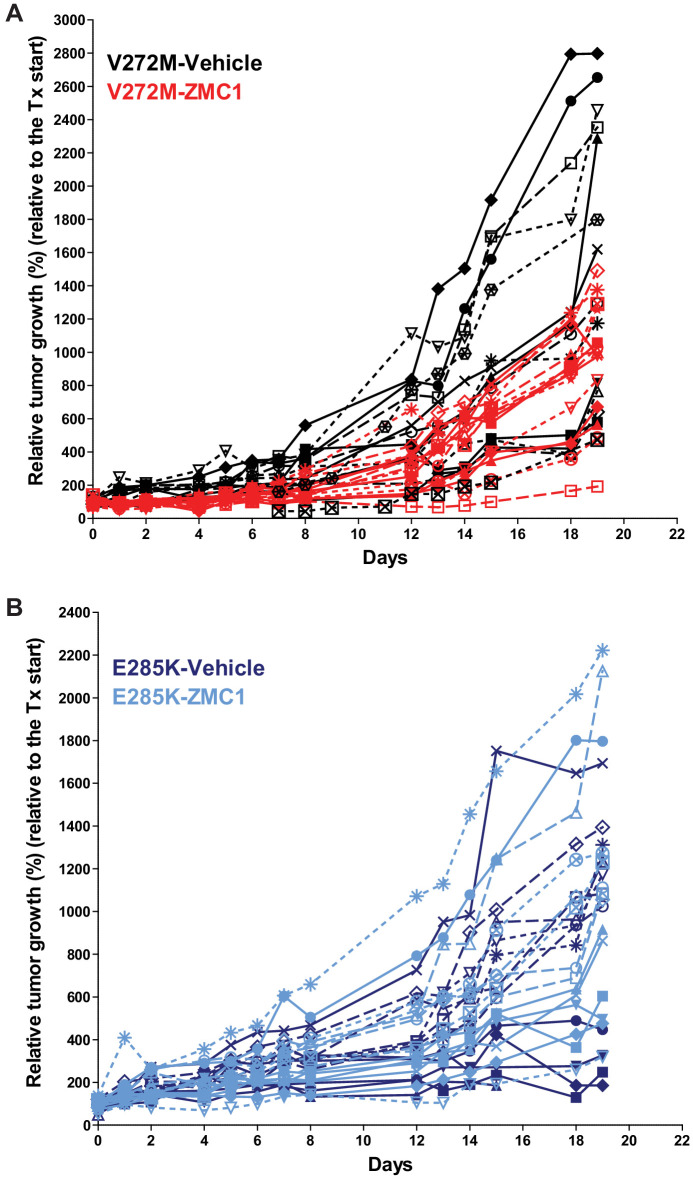
Individual tumor growth curves for the processed data presented in Figure 5.Tumor growth shows the in vivo efficacy of ZMC1 in stability-class mutant V272M (A) but not in E285K (B).